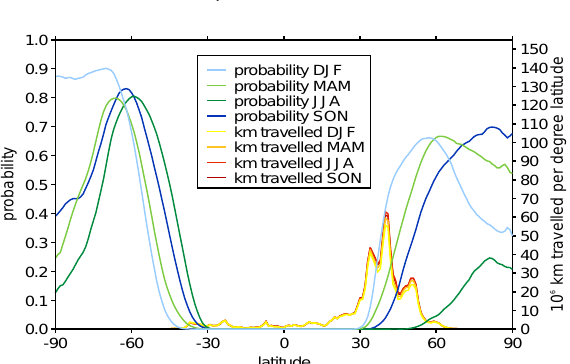
traffic data for three adjacent altitude ranges per pressure level have been included in Fig. 5 as well. Thus, each pres- sure level is identified here with a range of six flight levels (air routes vertically stacked in 10 hft, i.e. 305 m, distance). This is done for illustration only and we do not claim